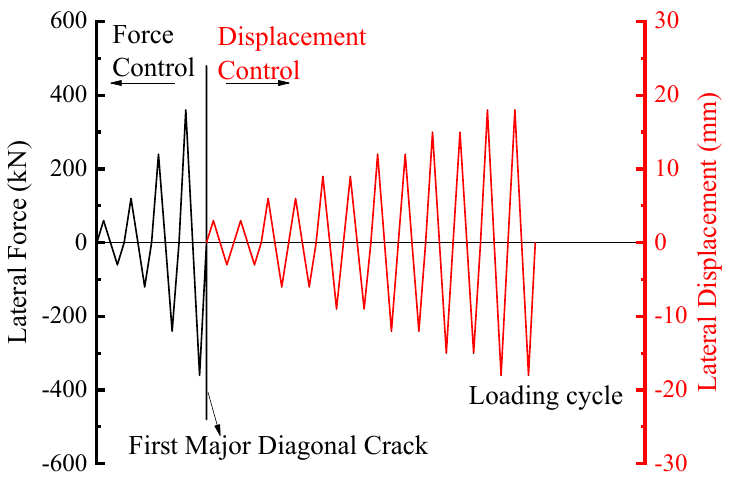
Figure 5. Loading procedure.